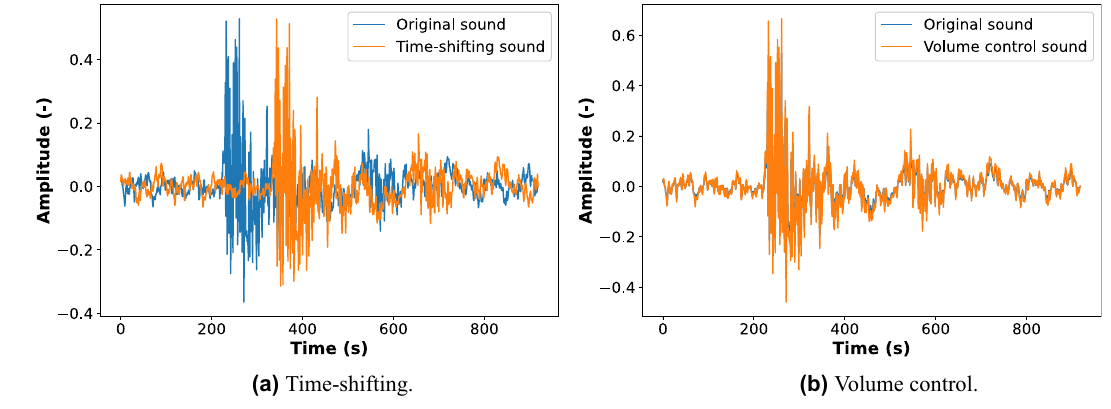
Figure 3. The time representation of the original fault sound and the augmented